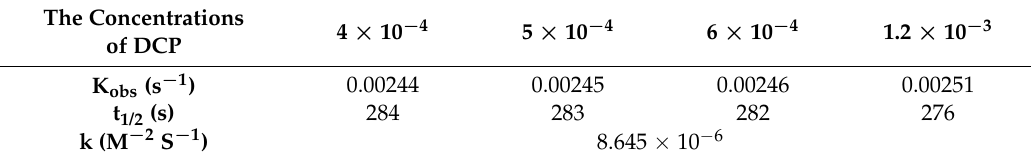
Figure 2. ( a ) Kinetic profiles of the fluorescence intensity at 583 nm of RB-CT ((1.0 × 10 − 6 M, CH 3 CN, 3% Et 3 N) after the addition of 4.0 × 10 − 4 M, 5.0 × 10 − 4 M, 6.0 × 10 − 4 M, and 1.2 × 10 − 3 M DCP. ( b )The correlation between k obs and the concentration of DCP. Table 1. Observed reaction rates (k obs ), half-life time (t 1/2 ), and the constant rates (k) for the reaction of